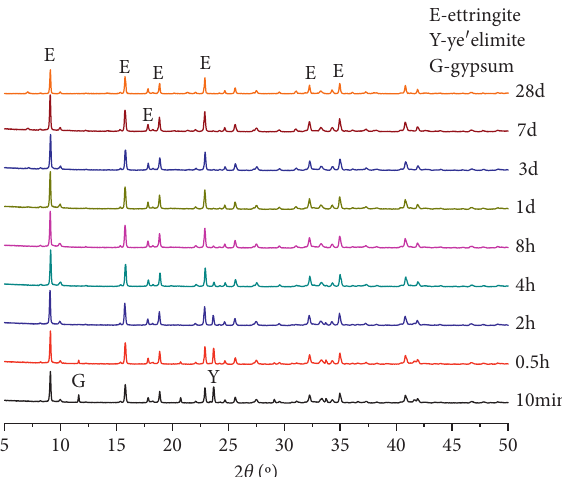
Figure 3: X-ray diffraction analysis of CSA-G under different hydration